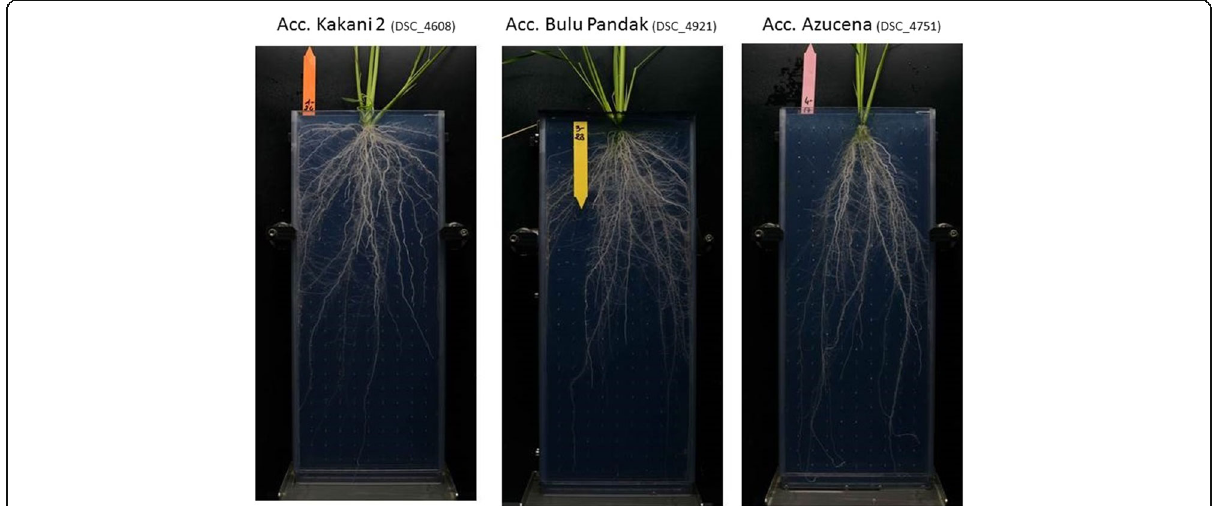
Fig. 4 Examples of root cone angle variation within the japonica panel. Kakani 2 and Bulu Pandak belong to the bulu ecotype and Azucena (check) is a tropical japonica